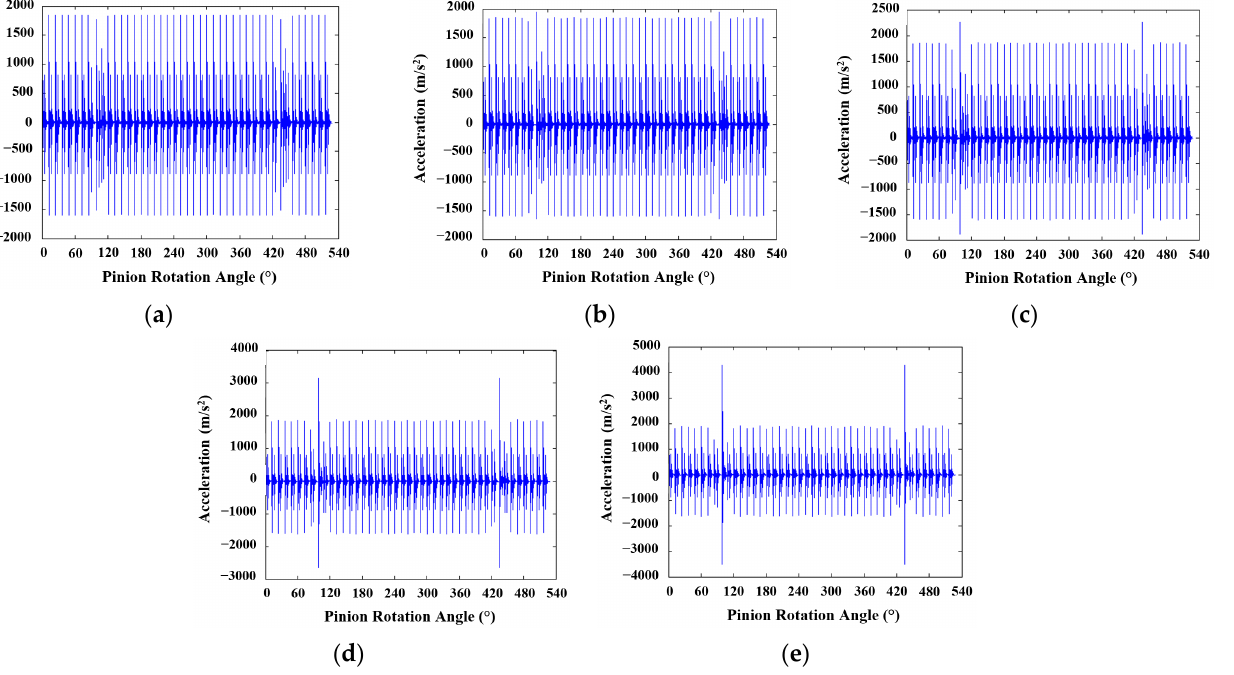
Figure 8. Vibration signals obtained for 20°/30° tooth pro fi le: ( a ) healthy; ( b ) 25%; ( c ) 50%; ( d ) 75%; ( e ) 100% crack levels.